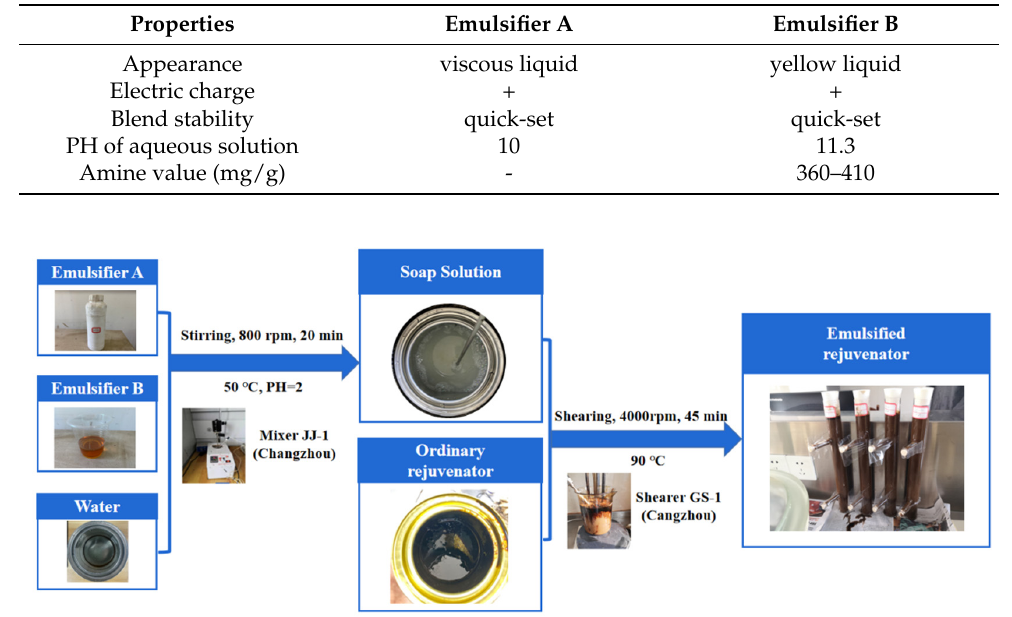
Figure 2. Rotational viscosity of ER and CR.